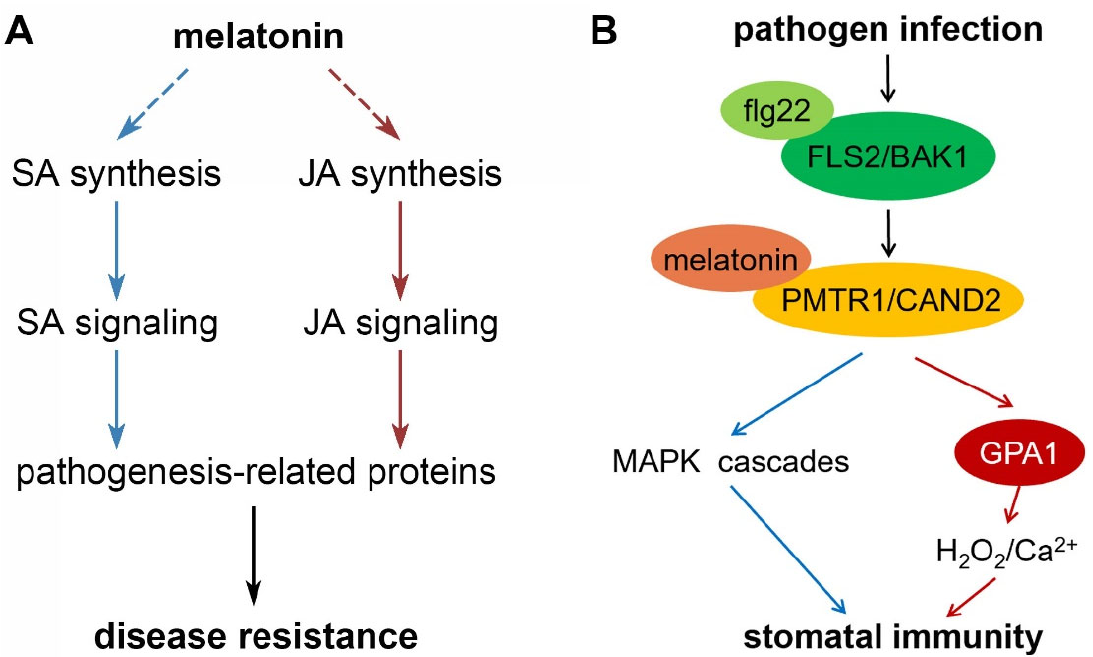
Figure 4. Two mechanisms of melatonin on the regulation of plant disease resistance. ( A ) Melatonin modulates the salicylic acid (SA) and jasmonic acid (JA) signaling cascades to enhance plant innate immunity against infection by various pathogens. The dotted lines indicate that the detailed processes remain unknown. ( B ) The PMTR1/CAND2 pathway regulates stomatal closure under pathogen infection. flg22: highly conserved N-terminal of flagellin epitope, recognized by FLS2; FLS2/BAK1: Flagellin Sensing 2/Brassinosteroid Insensitive 1-associated kinase 1; GPA1: G protein α subunit; PMTR1/CAND2: phyto-melatonin receptor; MAPK: mitogen-activated protein kinase.